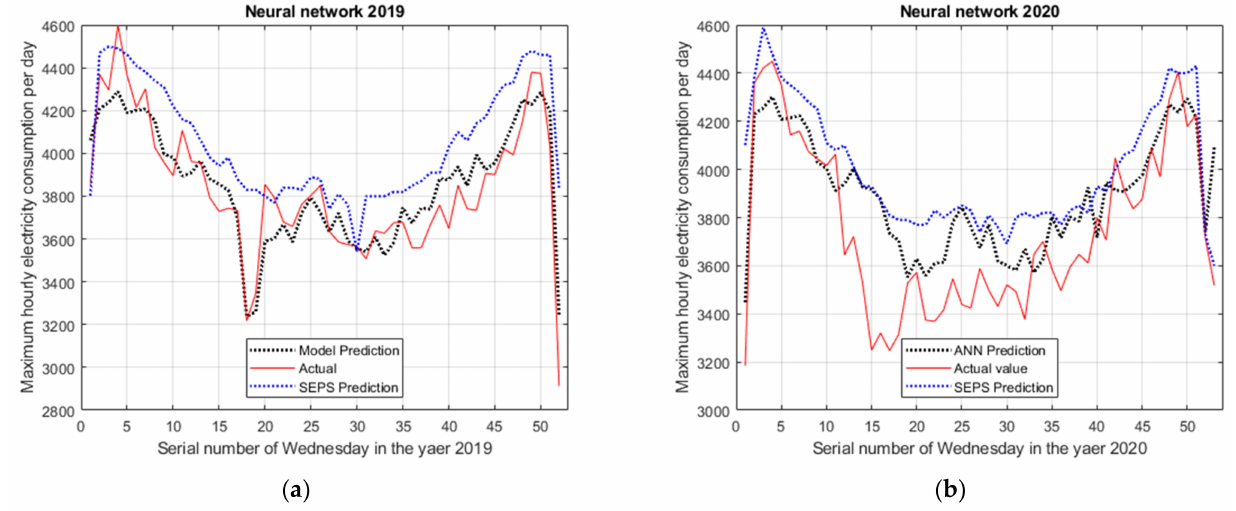
Figure 10. Prediction of ANN. ( a ) Prediction of ANN for 2019, ( b ) Prediction of ANN for